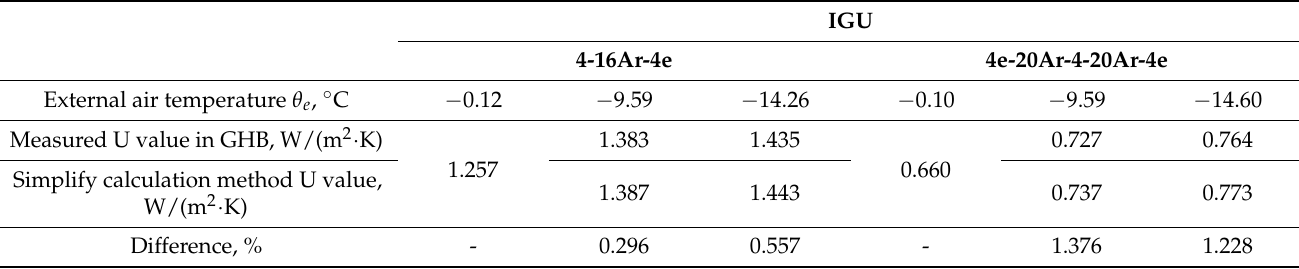
Table 10. The comparison of U-values of IGU measured in Hot Box and calculated according to simplified